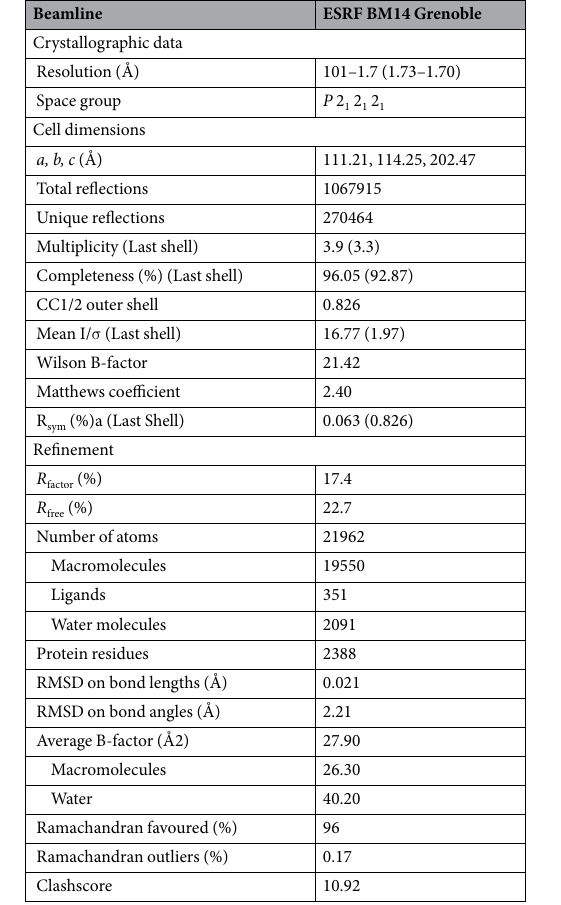
Table 1. Summary of data collection, structure refinement, and validation statistics. * Statistics for the highest- resolution shell are shown in parentheses. a R sym = Σ hkl Σ in = 1 |I hkl,i − [overbar]I hkl |/ Σ hkl Σ in = 1 |I hkl,i